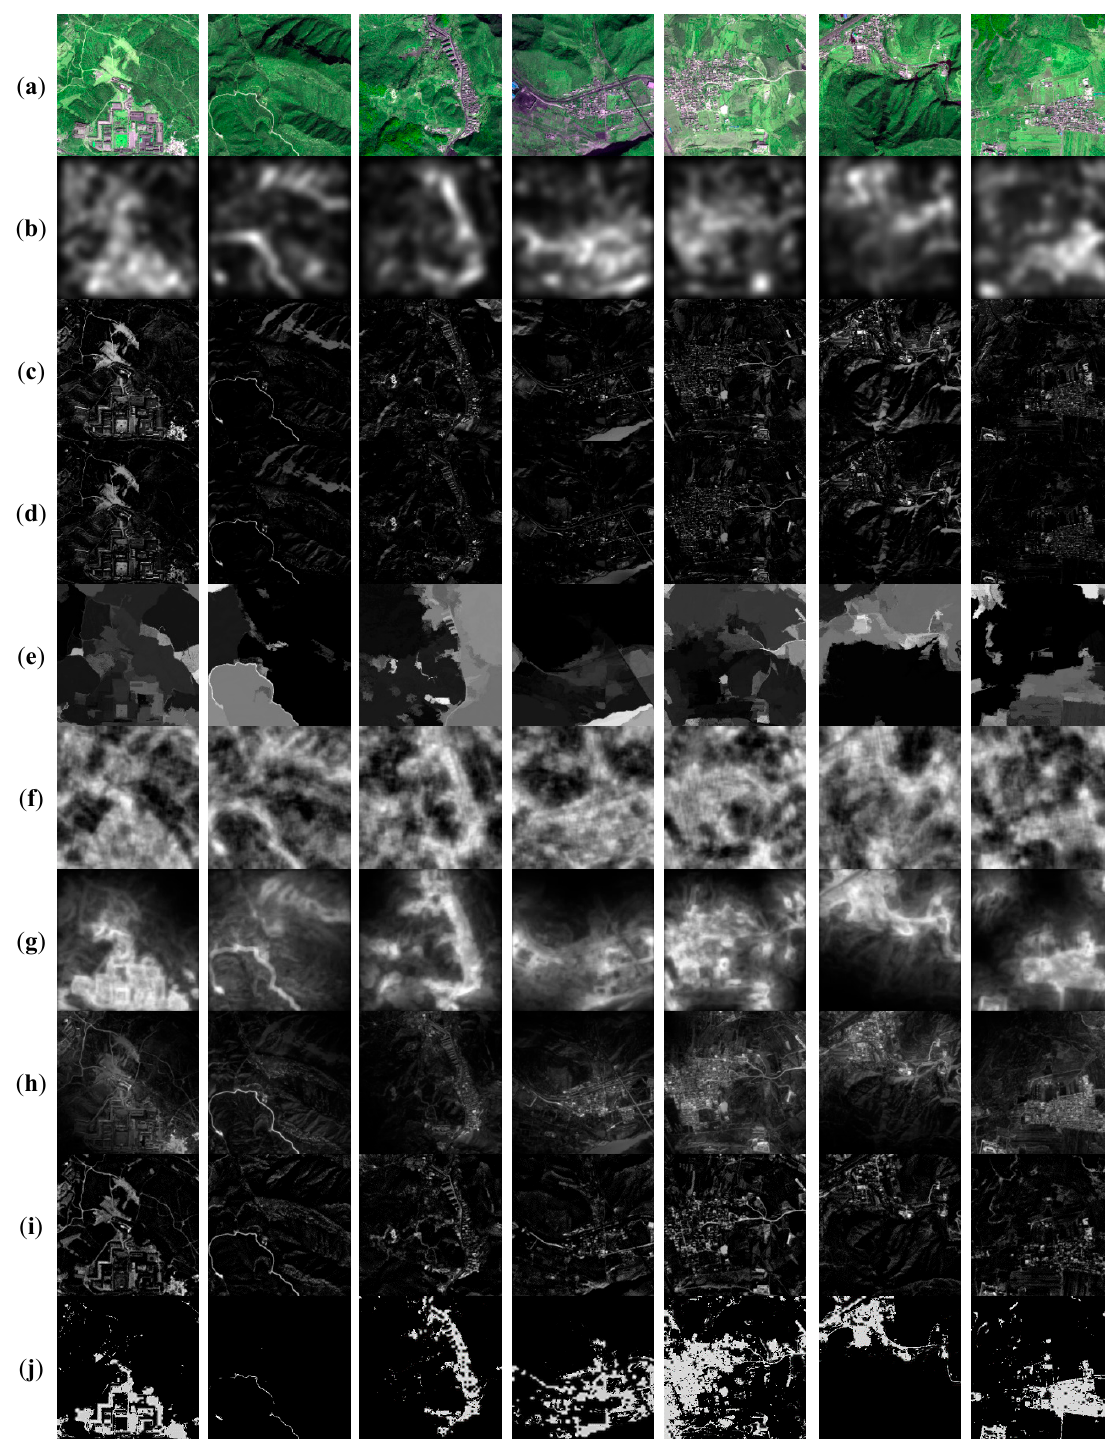
Figure 12. Visual comparison of saliency maps from Group GeoEye - Residential area . From top to bottom are ( a ) input images; ( b ) ITTI; ( c ) FT; ( d ) MSSS; ( e ) CB; ( f ) SIM; ( g ) CA; ( h ) TMM; ( i ) FDA-SRD; and ( j ) our JMS model.